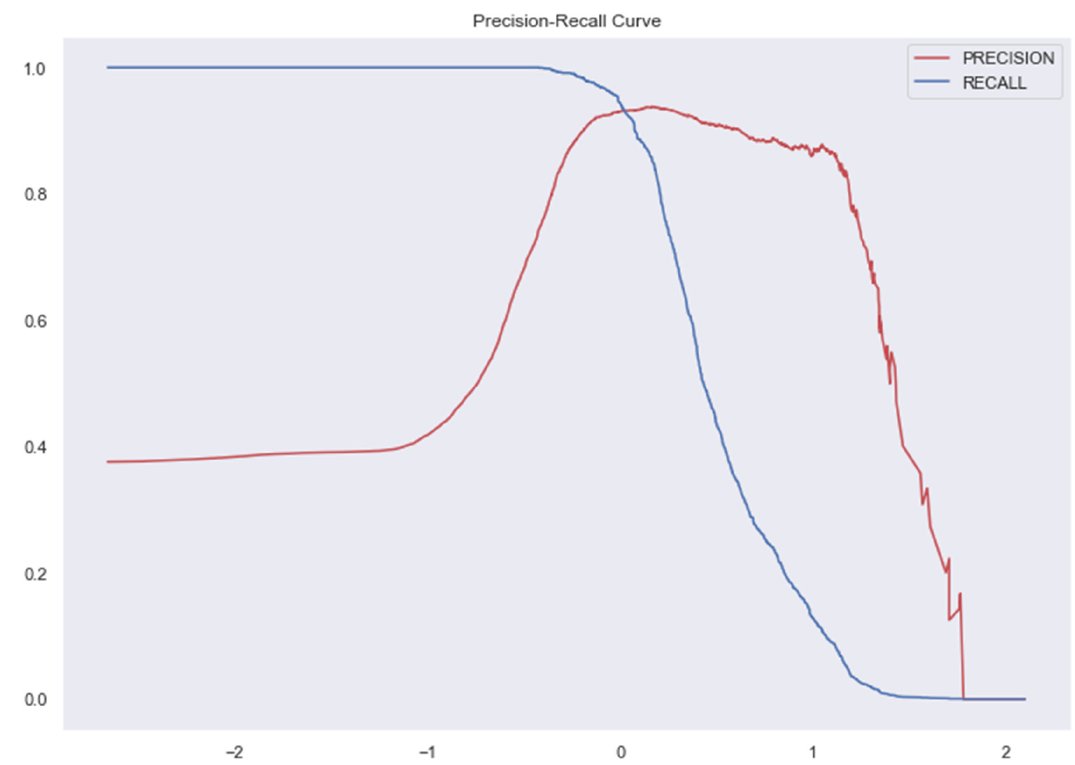
Figure 12. AUC and Precision-Recall Curve for Gradient Boosting Classifier.